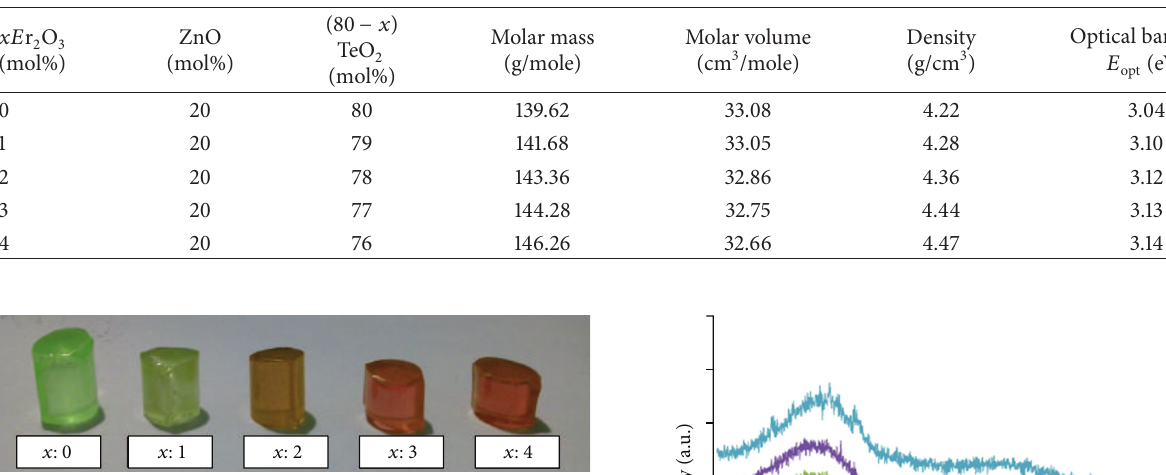
O -20ZnO-( 80 − 𝑥 )TeO 2 3